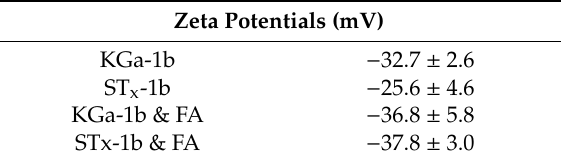
Table 1. Zeta potentials of clay colloids in the presence and absence of FA.